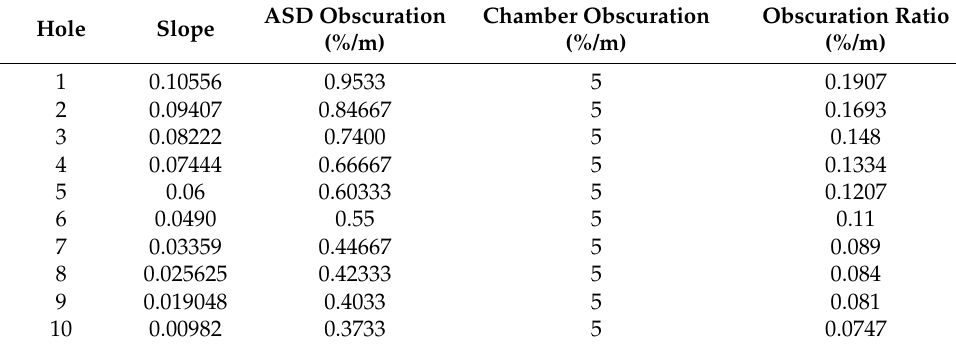
Table 6. The slope and obscuration ratio at ASD 1 when chamber obscuration is 5%/m.